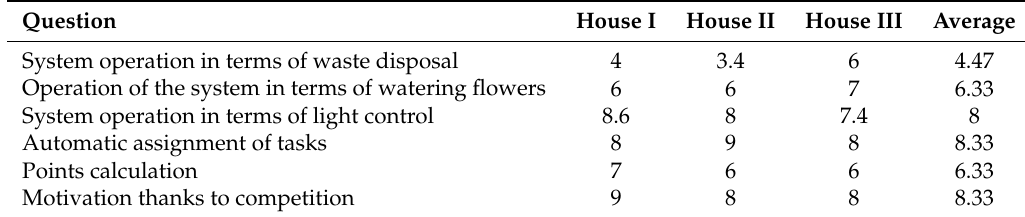
Table 3. Question and answers questionnaire on a scale of (cid:104) 0,10 (cid:105)